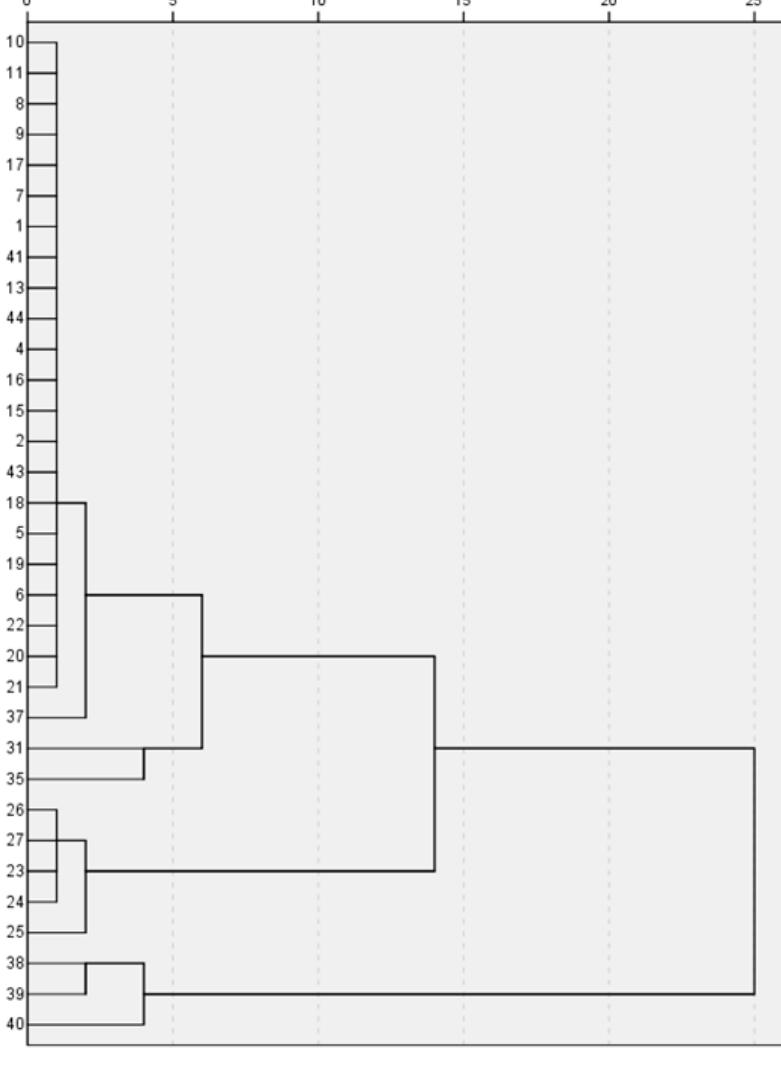
Figure 5. Dendrogram for hierarchical clustering by Statistical Product and Service Solutions (SPSS) of 44 samples of Fritillariae Bulbus.